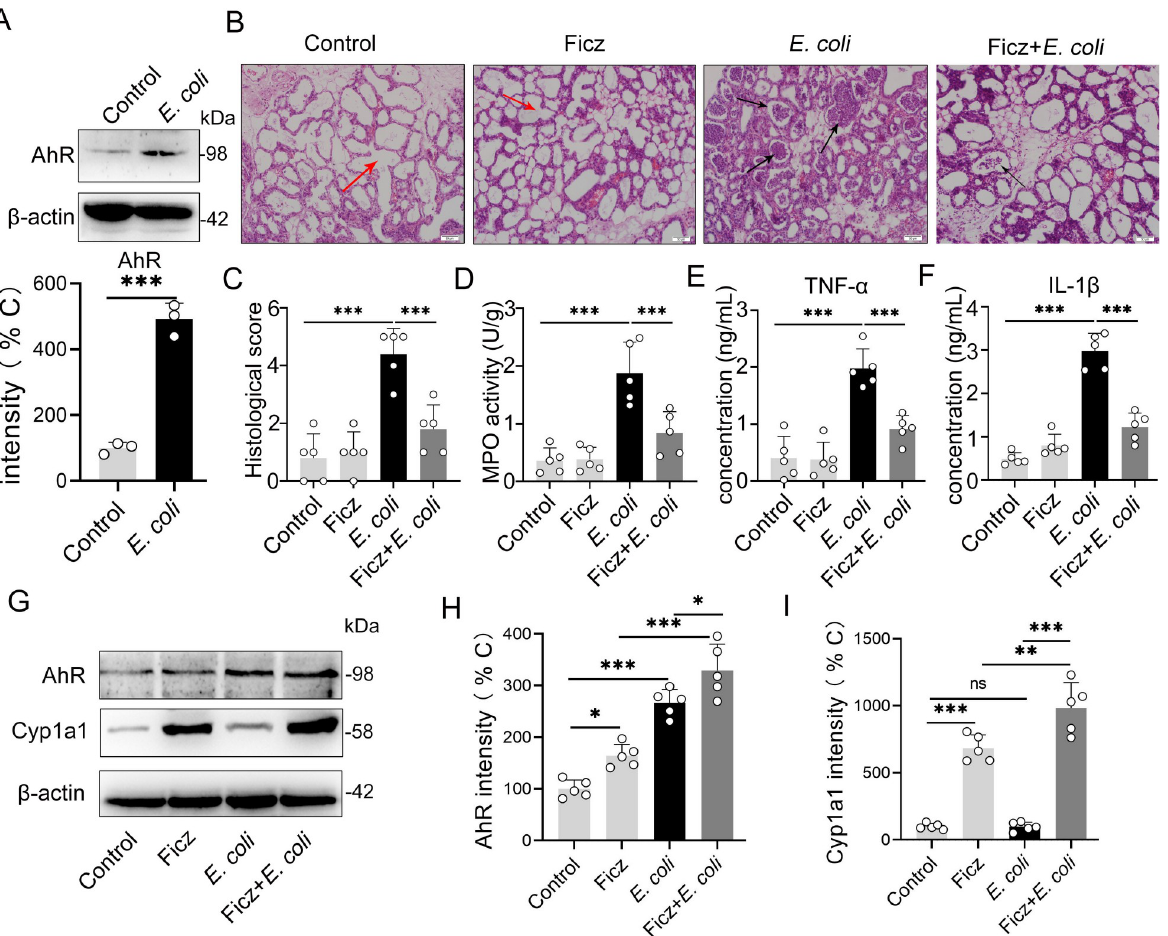
Fig 1. AhR activation by Ficz alleviates E . coli -induced mastitis. Mammary gland tissues were harvested from control, E . coli (10 7 CFU/50 μ L each breast duct) treated and Ficz (1 μ g/mouse) pretreated mice 24 h after E . coli treatment. (A ) AhR protein expression in mammary gland tissues from control and E . coli- treated mice was detected using western blotting (n = 3). (B) H&E-stained mammary gland tissue sections (scale bar, 50 μ m). The red arrow indicates normal alveolar cells. The black arrow indicates the inflammatory cells infiltration. ( C) Histological score according to the degree of alveolar injury and inflammatory cell infiltration (n = 5). ( D ) Levels of MPO activity (n = 5). The expression of pro- inflammatory cytokines TNF- α ( E ) and IL-1 β ( F ) was measured by ELISA (n = 5). ( G-I ) AhR and Cyp1a1 levels in mammary gland tissues (n = 5). The results are shown as the means ± SEM. T test ( A ) and one-way analysis of variance ( C-F, H-I ) was used for statistical analysis. � p < 0.05, �� p < 0.01 and ��� p < 0.001 indicate significant differences from each group. ns, no significance.